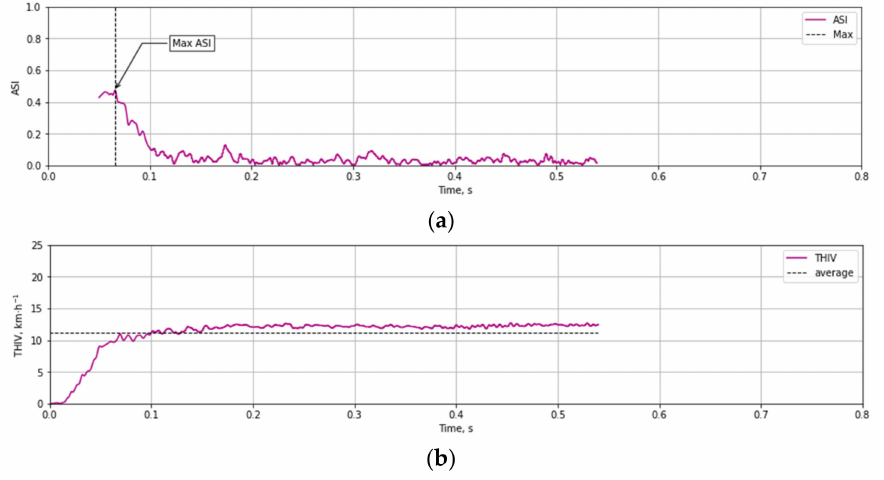
Figure 18. Numerical courses of the values of injury intensity parameters ( a ) ASI, ( b ) THIV as a result of an impact against T03 mast at 100 km/h.